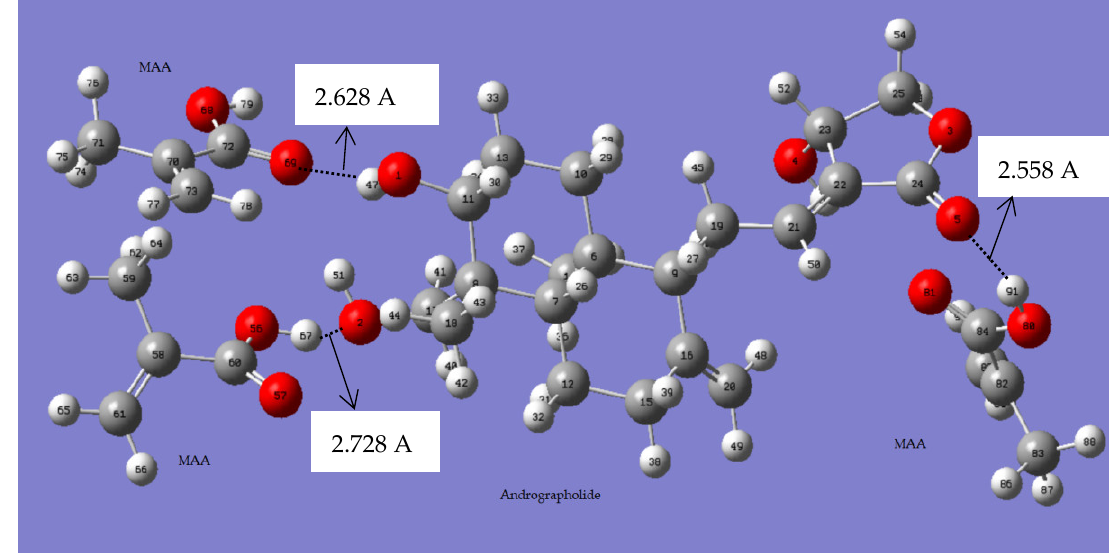
Figure 2. Predicted interaction between andrographolide and MAA (performed by Gaussian W 09).